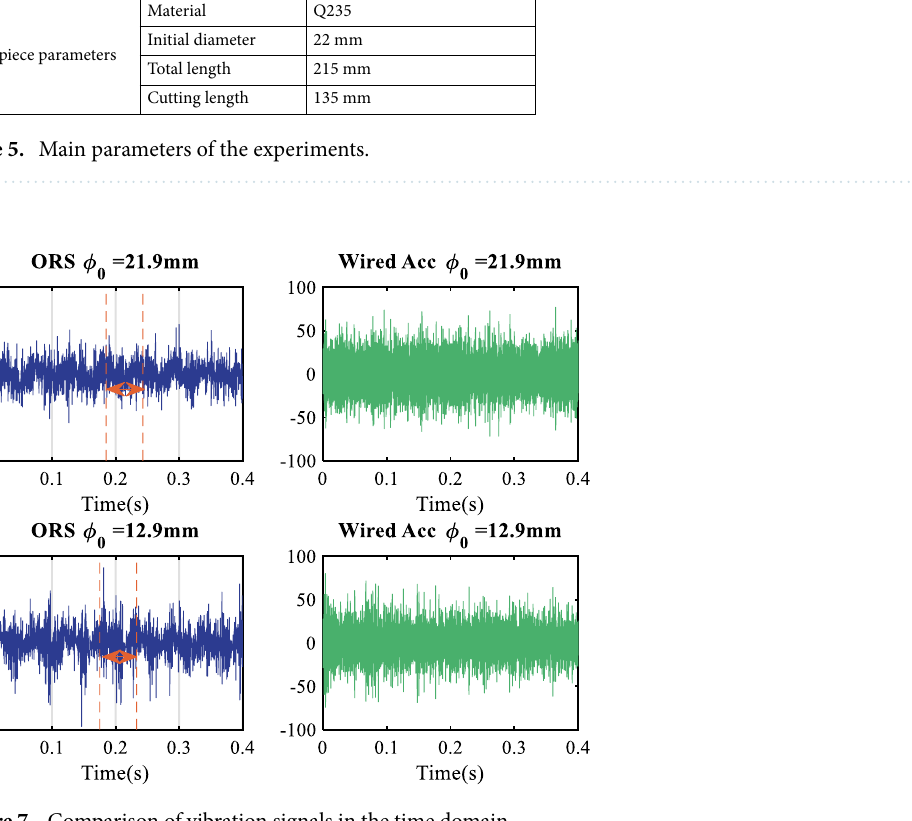
Figure 7. Comparison of vibration signals in the time domain.